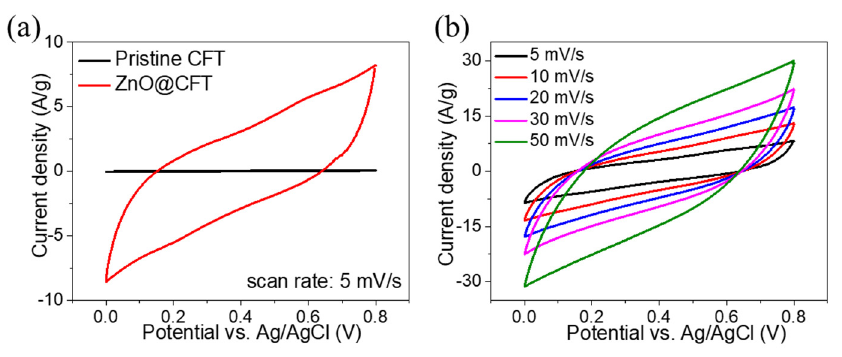
Figure 5. N 2 adsorption and desorption isotherms of ZnO nano-flowers ( a ) and pore-size distribu- tion of ZnO nano-flowers ( b ).